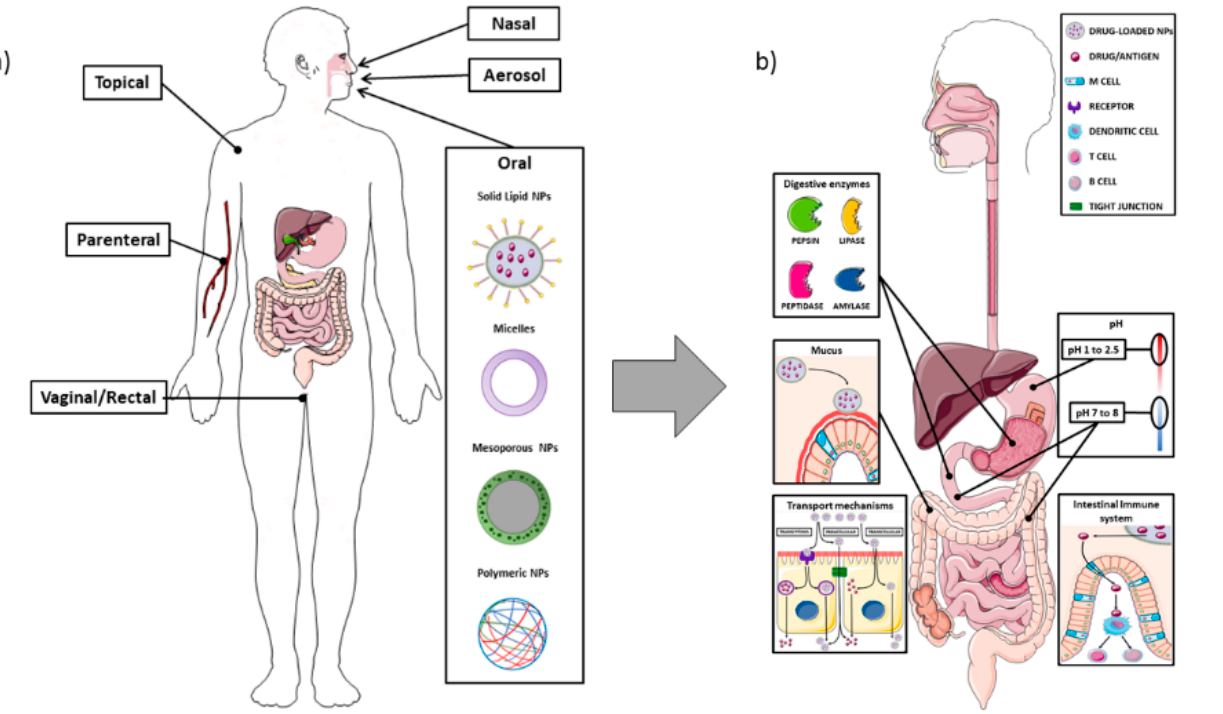
Figure 2. Schematic representation of the different routes for nanoparticle drug delivery, with attention to the oral administration and the interactions with the intestinal barrier. Panel ( a ): Overview of the main administration routes for nano-drug delivery; Panel ( b ): Different enzymes (pepsin, lipase, peptidase, and amylase) located in the gastrointestinal tract can impair nanocarriers stability and their ability to reach the target tissue. The mucus layer also plays an important role in the entrapment of NPs, which may lead to reduced uptake at cellular level. The enterocytes transport mechanisms of NPs can occur through the intestinal cells, either by transcytosis (mediated by endocytic vesicles), or through a direct apical-basolateral passage, or by the paracellular route (passing through the intercellular space). The difference in pH among the stomach, duodenum, and colon represent one of the main challenges in delivering NPs, particularly in order to avoid their premature degradation through the acidic environment. M cells, as part of the GALT (gut-associated lymphoid tissue), can detect antigens from the intestinal lumen and bring them to antigen presenting cells (APC), which, in turn, are able to present them to B or T lymphocytes located at the mucosal level. The image was created with the use of Servier Medical Art modified templates, licensed under a Creative Common Attribution 3.0 Unported License (https://smart.servier.com, accessed on 19 February 2022).